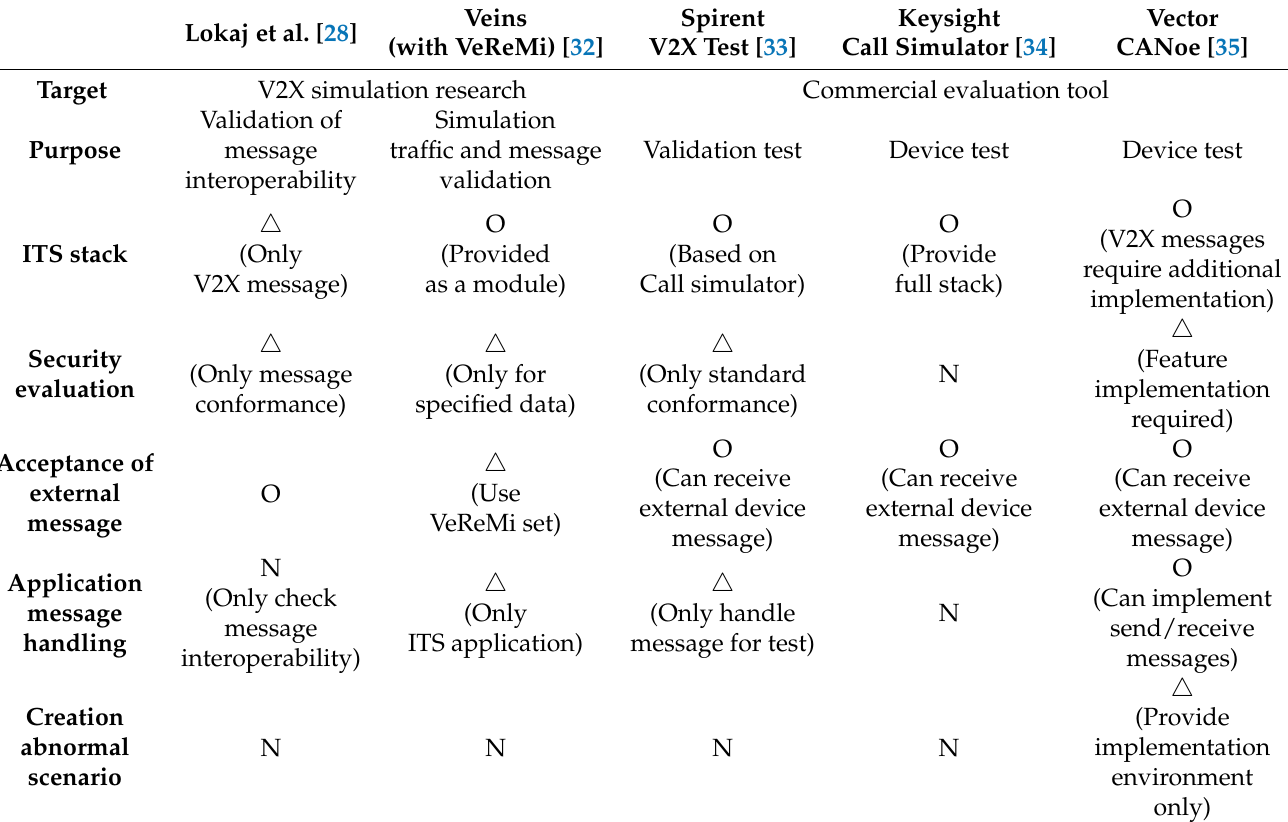
Table 2. Comparison of requirements for V2X simulation and testing tools for security evaluation scenario